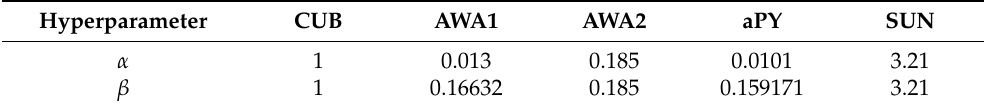
Table 2. Meta Decision Tree